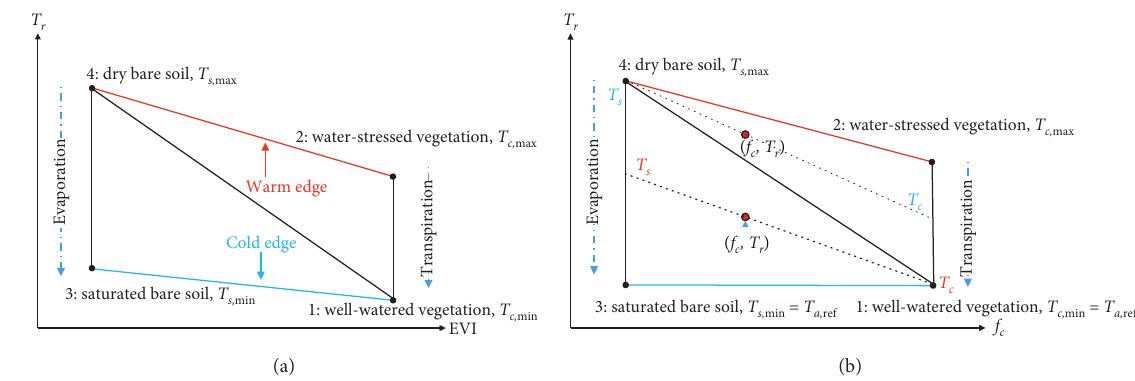
Figure 1: Trapezoidal space: (a) the T r -VI proposed by Wang et al. [34] and Wang et al. [4]; (b) the T r - f c constructed in this study. The T a ,ref is the averaged T a of well-watered